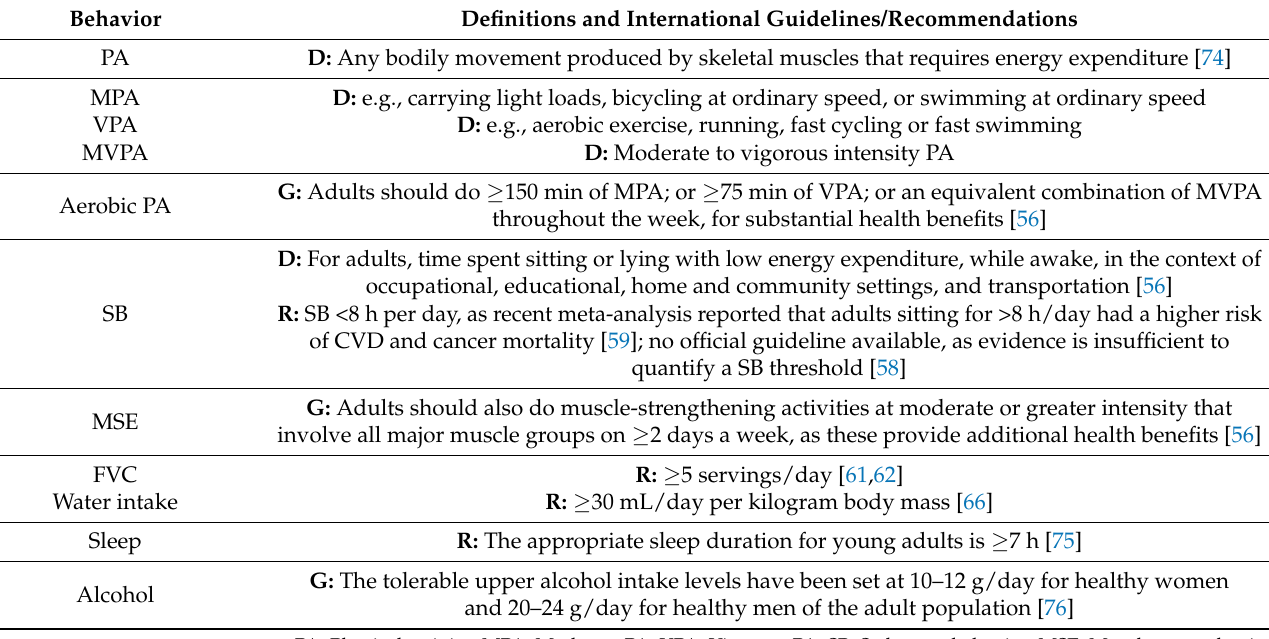
Table 1. Definitions and international guidelines/recommendations of terms used. Behavior Definitions and International